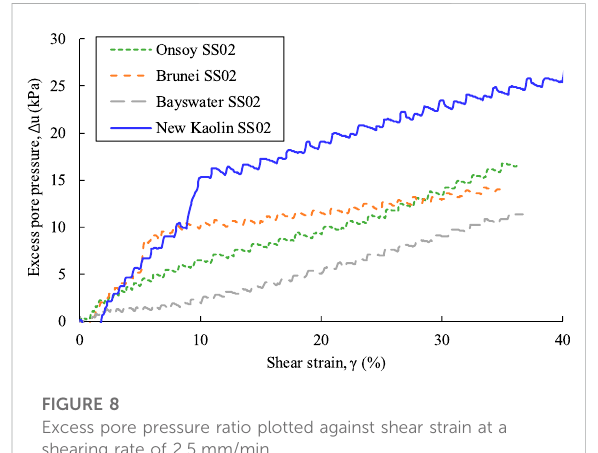
FIGURE 9 Variation in excess pore pressure ratio with specimen height, both at